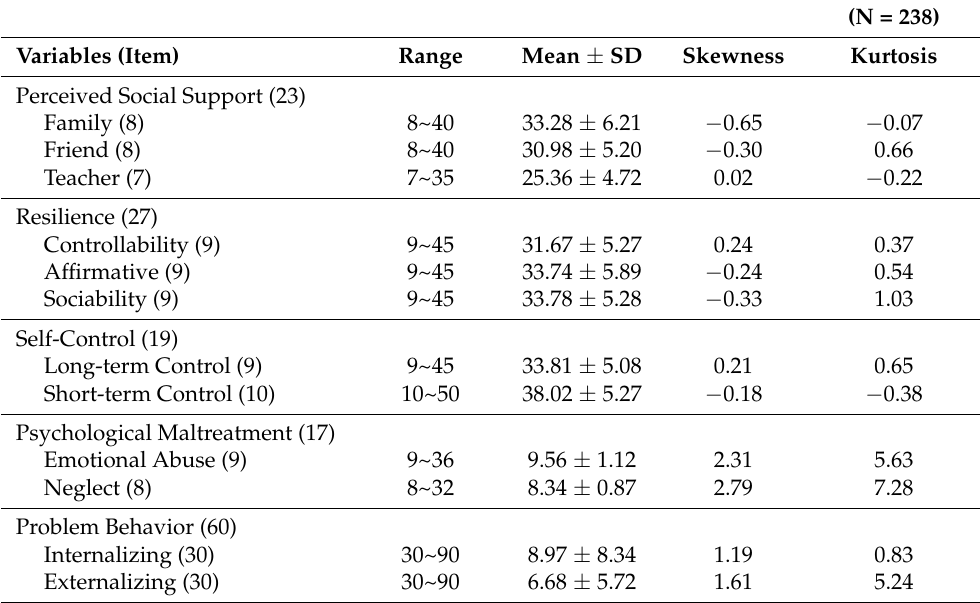
Table 2. Descriptive Statistics of Study